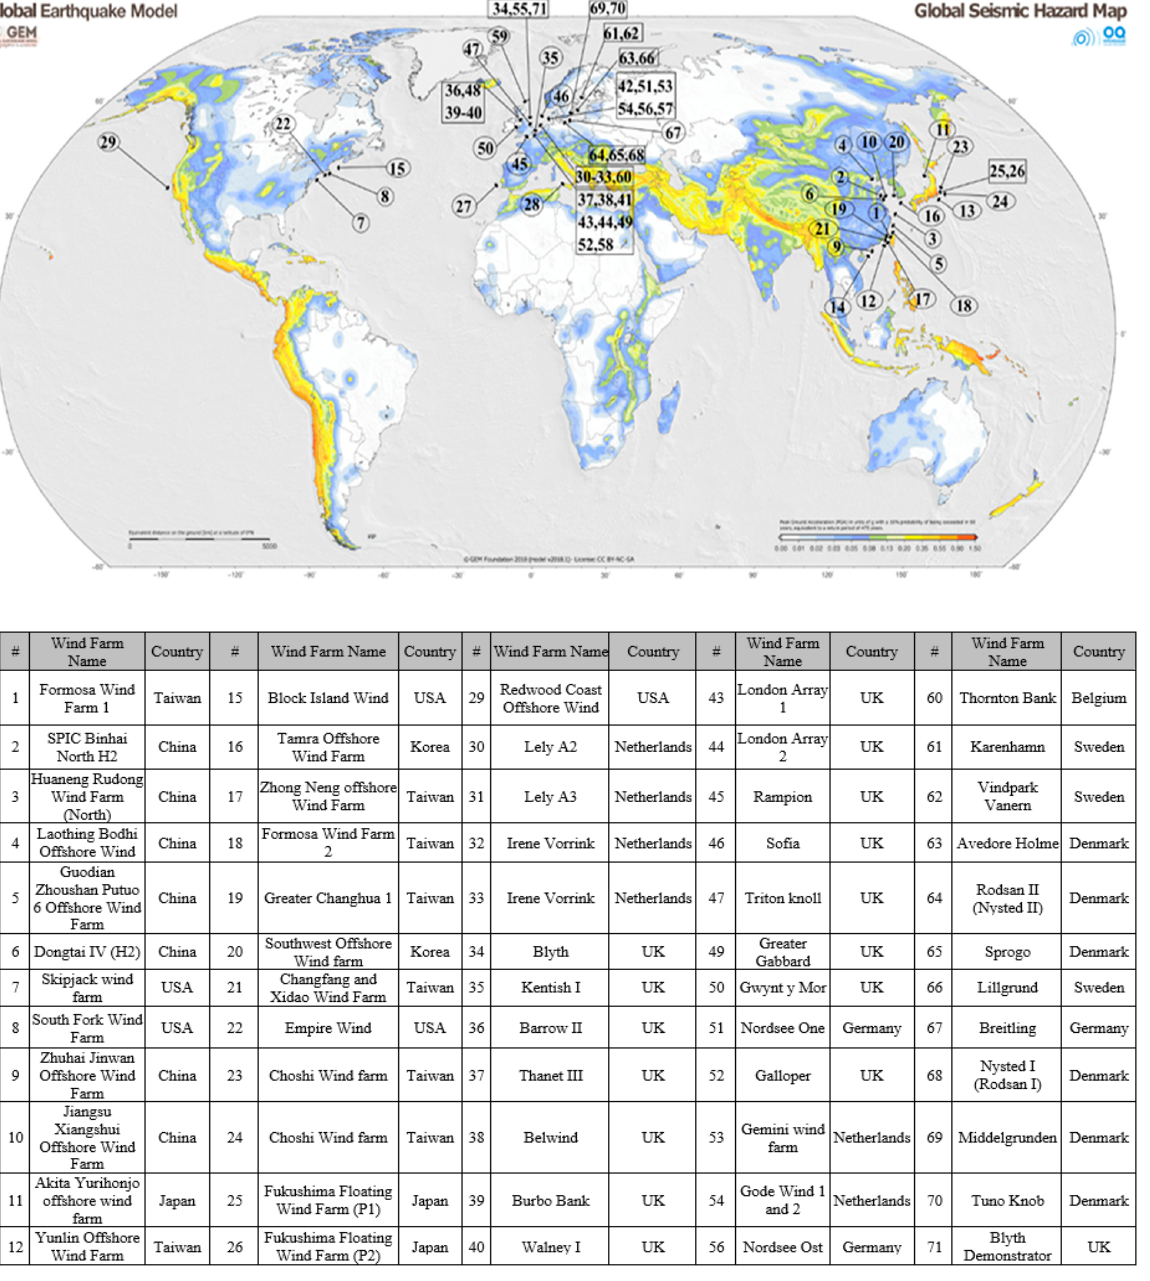
Figure 1. Investments in offshore wind farm, with seismicity. The base map of the GEM model is from [1]. The data for offshore wind farms is collated from various publicly available